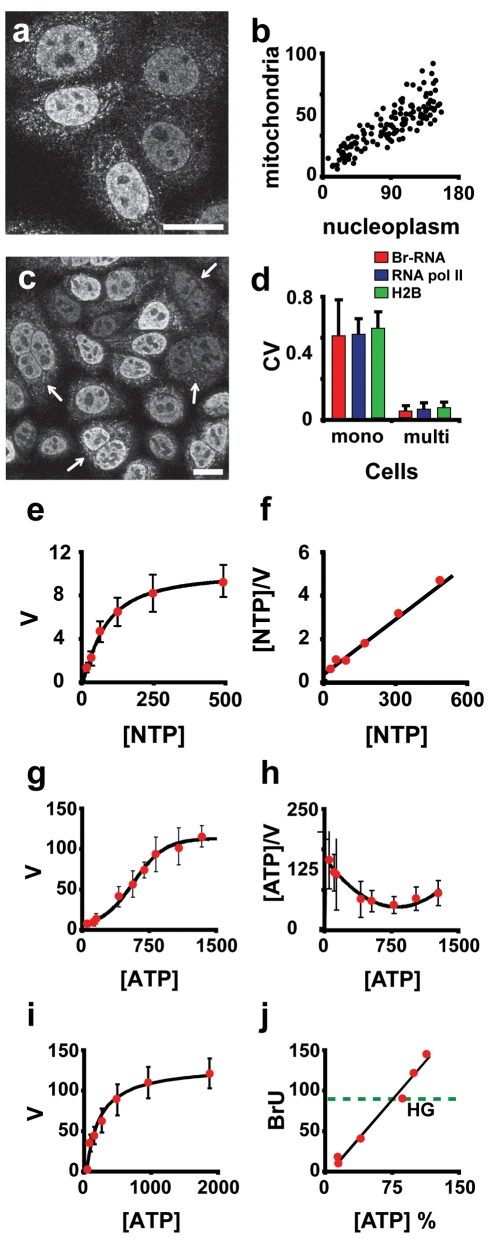
Kinetics of RNA pol II in situ: effect of NTP concentration.(A) Transcription in the nucleus and mitochondria are related. Br-RNA was immunodetected in cells after BrU incorporation. Cells with a very actively transcribing nucleus also have high levels of transcription in the mitochondria. (B) Analysis of Br-RNA signals in nucleoplasm versus mitochondria (arbitrary units) in images like that in (A) (confocal images). (C) Cells were fused using polyethylene glycol and after 2.5 h were exposed for 30 min to 2.5 mM BrU. Arrows point to fused cells, where signals in nuclei sharing the same cytoplasm present very similar intensities. (D) Analysis of the CV between nuclei of neighbouring cells (mono) and nuclei sharing the same cytoplasm (multi); CV of Br-RNA incorporation (red columns), CV of RNA pol II elongating (blue columns), and CV of the dynamics of exchange of histone H2B (green columns). (E) Study of the enzymatic kinetic properties of RNA pol II with respect to [NTP]. The assay was performed as described in Figure S5, using as a tracer the incorporation of BrUTP into the nascent transcripts of Hela cells. This panel shows the dependence of transcription rate, V (arbitrary units/minute) on NTP concentration (micromoles). The experimental data fit a hyperbolic curve consistent with Michaelis-Menten kinetics. (F) Plot of [NTP]/V versus [NTP]; the straight line obtained suggests that RNA pol II has Michaelis-Menten-like kinetics [28]. (G) Dependence of V on ATP concentration (micromoles) using normotonic conditions. This curve shows a sigmoidal pattern. (H) Plot of [ATP]/V versus [ATP] suggests that RNA pol II is allosteric with respect to ATP. The sigmoidal curve of V versus [ATP] suggests that the rate of BrUTP incorporation has a quadratic dependence on [ATP]. (I) Repetition of (G) but using swollen cells (hypotonic shock) in order to decondense the chromatin. Under these conditions, the kinetics of RNA pol II with respect to [ATP] appears hyperbolic. (J) Effect of intracellular [ATP] on BrU incorporation. The intracellular [ATP] was perturbed by incubation with DG (25 mM) and no glucose for 12 h, which decreases [ATP], or incubation with succinate (5 and 10 mM) for 30 min, which increases [ATP]. Green dotted line represents BrU incorporation under ATP control conditions (high glucose, 4.5 g/l). Bars = 10 µm.